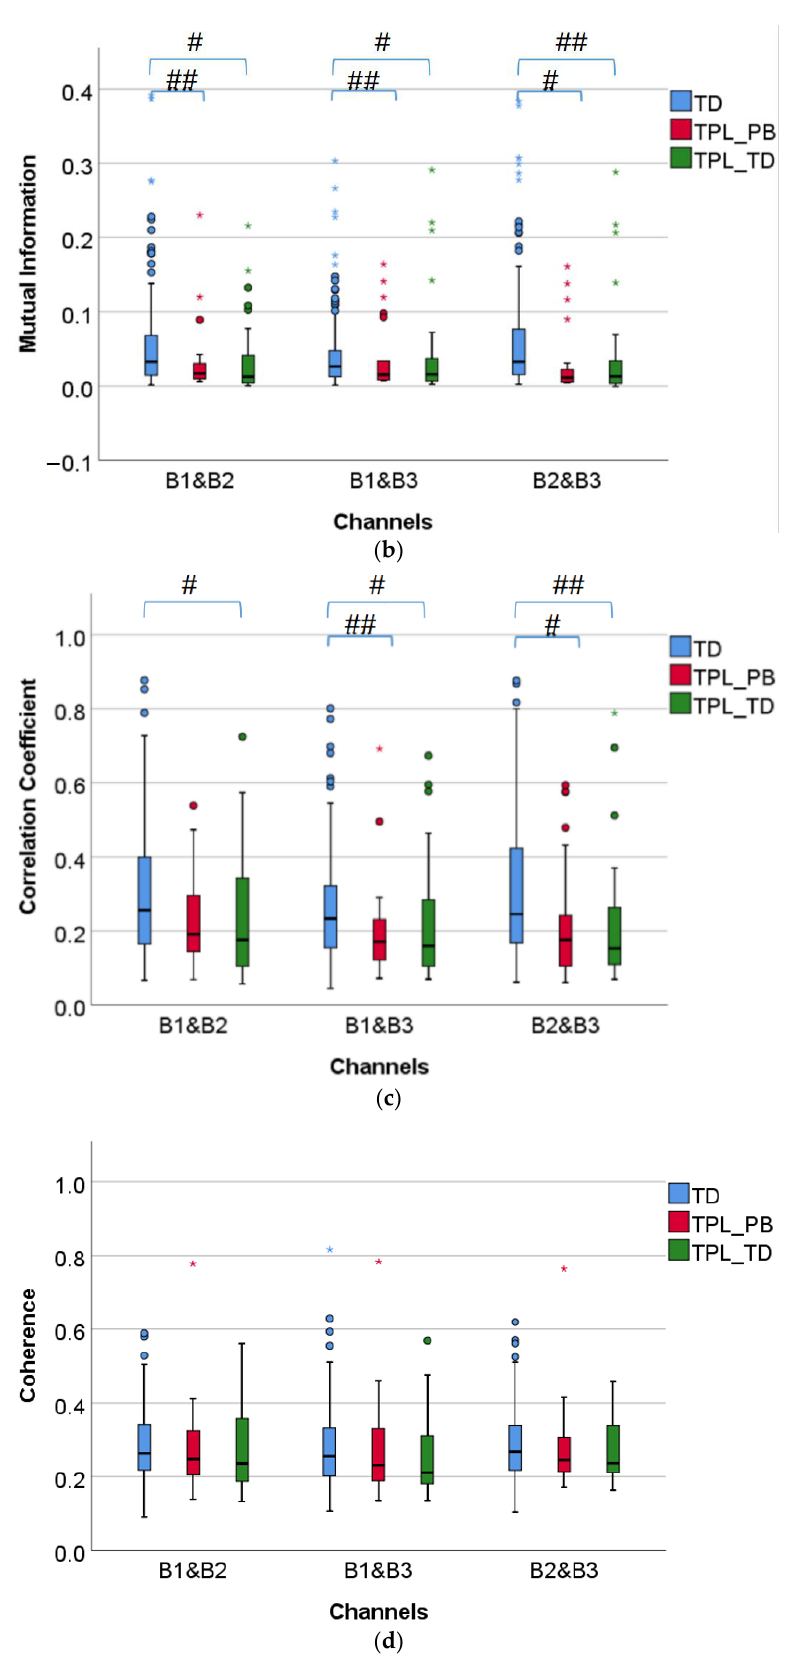
Figure 3. Comparison of coupling information between TD, TPL_PB, and TPL_TD. #: p < 0.05, ##: p < 0.01, : the moderate outlier, *: the extreme outlier. ( a ) Multivariate sample entropy; ( b ) Mutual (cid:35) information; ( c ) Correlation coefficient; ( d )